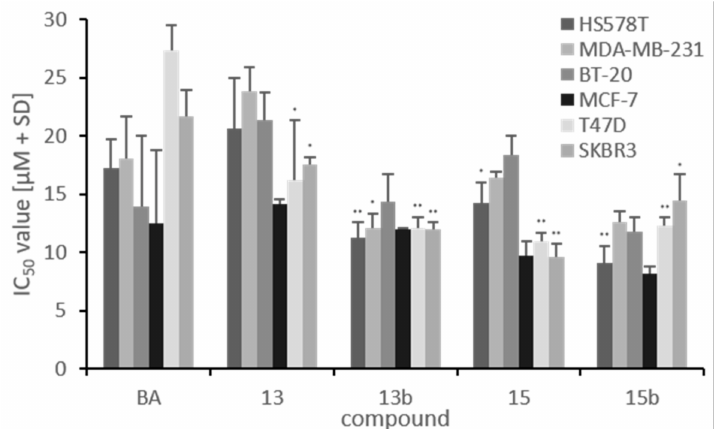
Figure 4. IC 50 values [ µ M] of betulinic acid and betulin derivatives. IC 50 values represent mean values (+SD) of at least three independent experiments. For each cell line, p values refer to the IC 50 value of BA. Significant p values are highlighted with asterisks (* p ≤ 0.05, ** p ≤